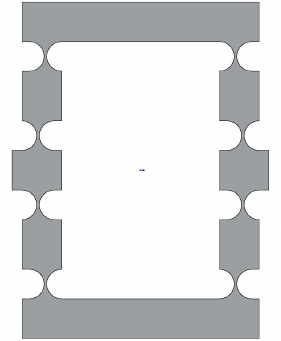
Figure 1. The basic bridge amplifier with right circular